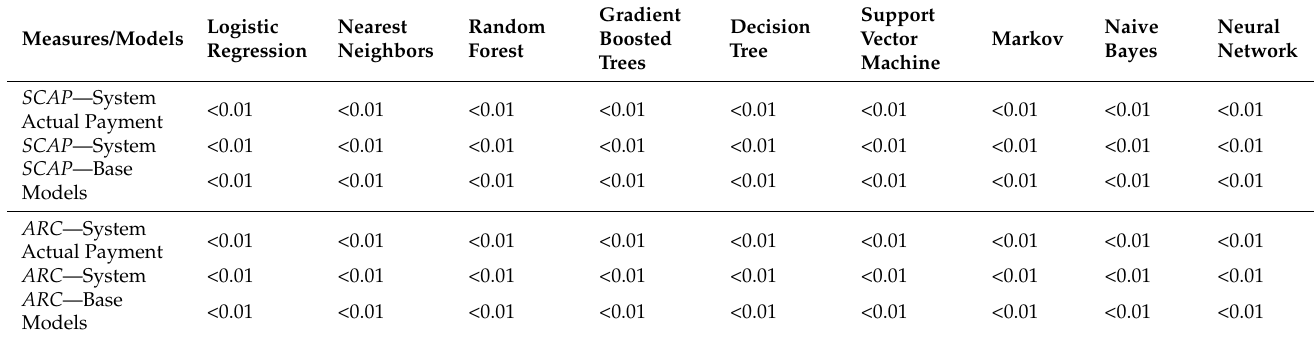
Table 4. Univariate tests of mean difference in performance of the Kelly strategy vs. alternative